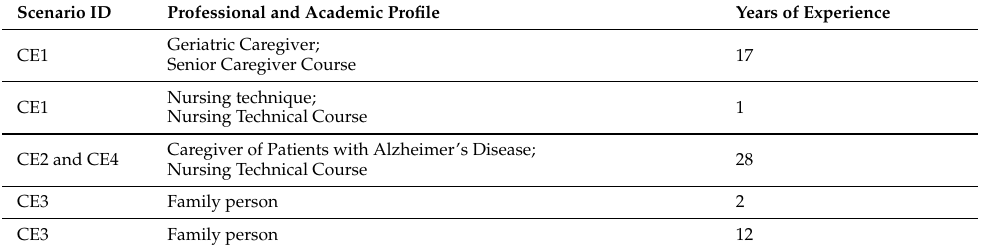
Table 2. Interviewee